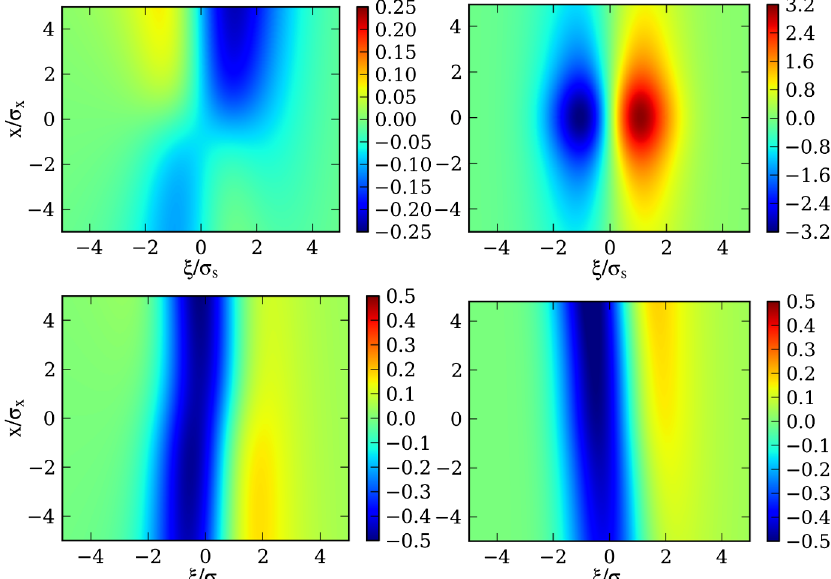
TWO DIMENSIONAL MODEL FOR COHERENT . .